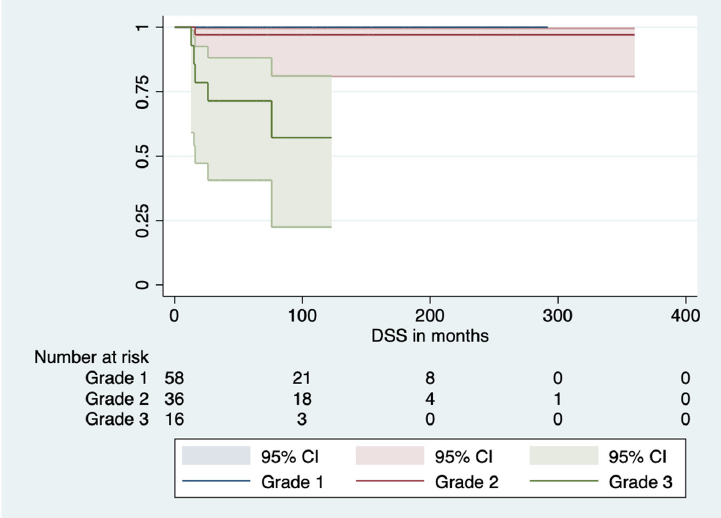
Figure 4. Only one patient with a grade 2 tumour died of the disease. The marginal status was not a signi fi cant factor for survival ( p = 0.553, HR 1.4; 95% CI: 0.5–3.6) (Figure 5).